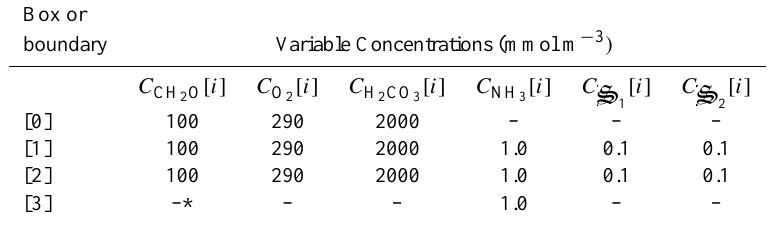
Table 2. Model initial conditions (for boxes [1] and [2]) and Dirichlet boundary conditions (for [0] and [3]) used for all model simulations. Box or boundary Variable Concentrations (mmol m − 3